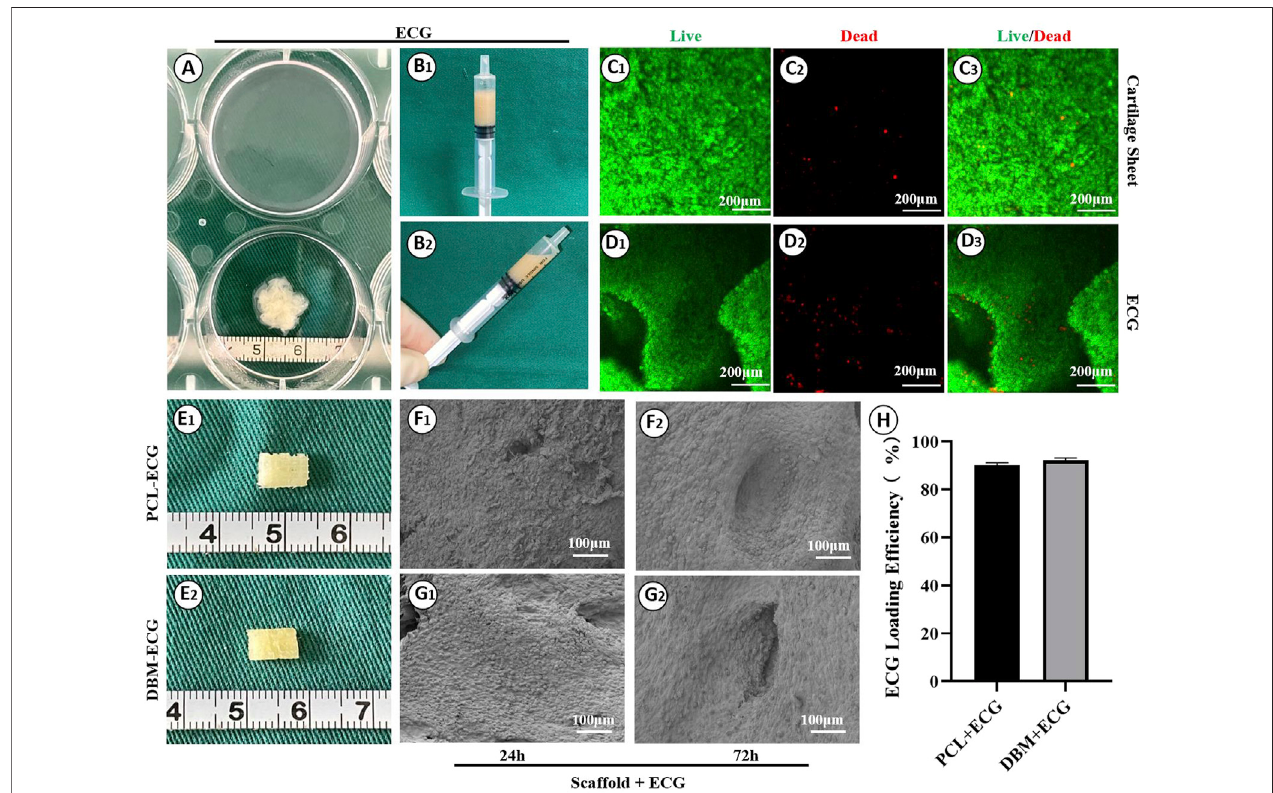
FIGURE 2| Preparation of engineered cartilage gel and its biocompatibility with the frameworks: Gross images ofcartilage sheet (A) and ECG (B1, B2) ; Live/dead stainingofcartilagesheet (C1 – C3) andECG (D1 – D3) ;GrossimagesofthePCL-ECG (E1) andDBM-ECG (E2) constructs;SEMimagesofPCL-ECG (F1,F2) andDBM- ECG (G1, G2) constructs after culture in vitro for 24 h and 72 h; (H) ECG loading ef fi ciency. Statistical signi fi cance: ns, no statistical signi fi